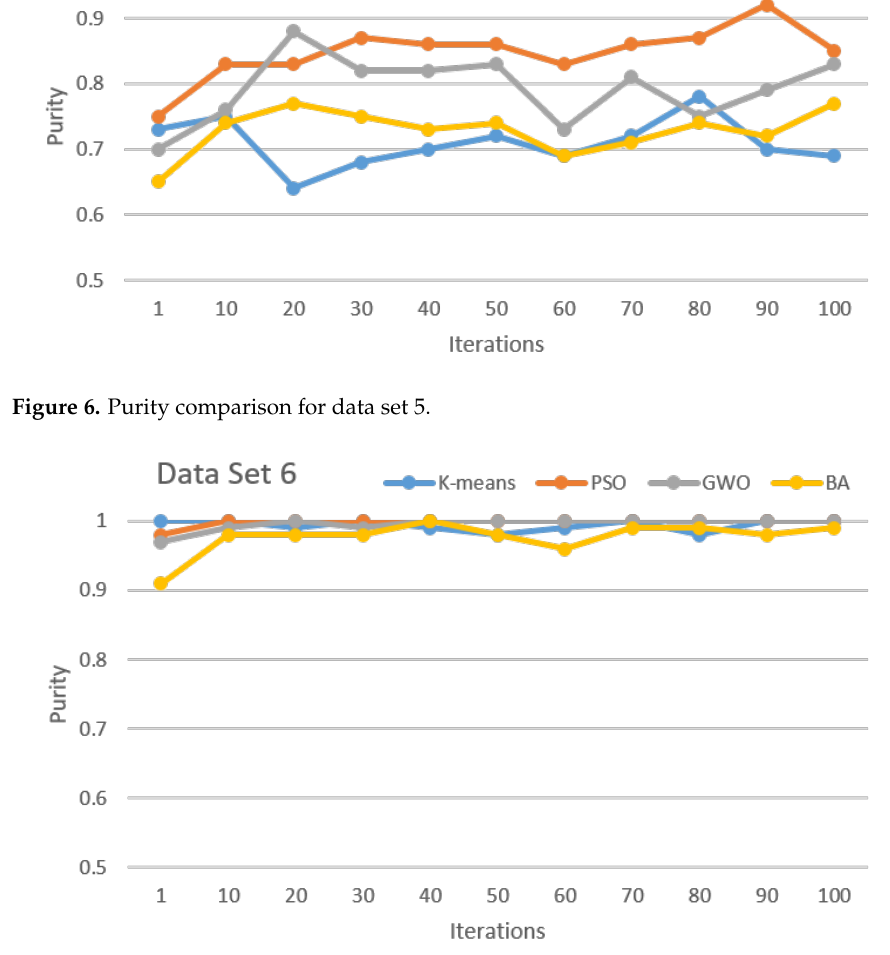
Figure 7. Purity comparison for data set